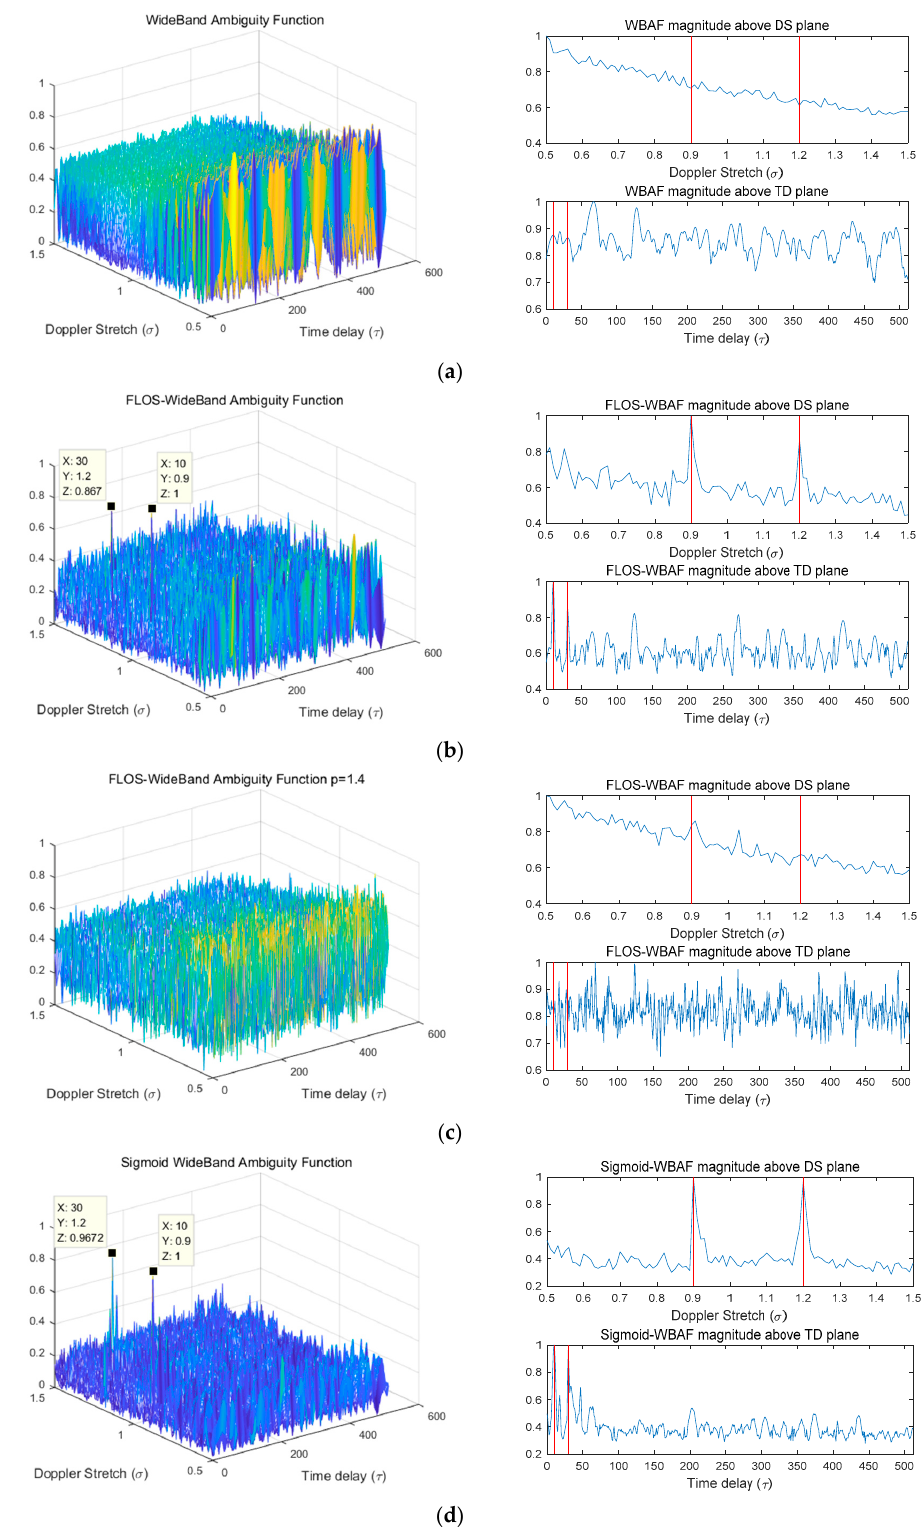
Figure 4. The normalized spectra of WBAF, FLOS-WBAF, and Sigmoid-WBAF for impulsive noise with GSNR = 2 dB and α = 1.2. ( a ) The 3D plot of WBAF and its DS and TD section planes; ( b ) the 3D plot of FLOS-WBAF with p = 1.1 and its DS and TD section planes; ( c ) the 3D plot of FLOS-WBAF with p = 1.4 and its DS and TD section planes; ( d ) the 3D plot of Sigmoid-WBAF and its DS and TD section